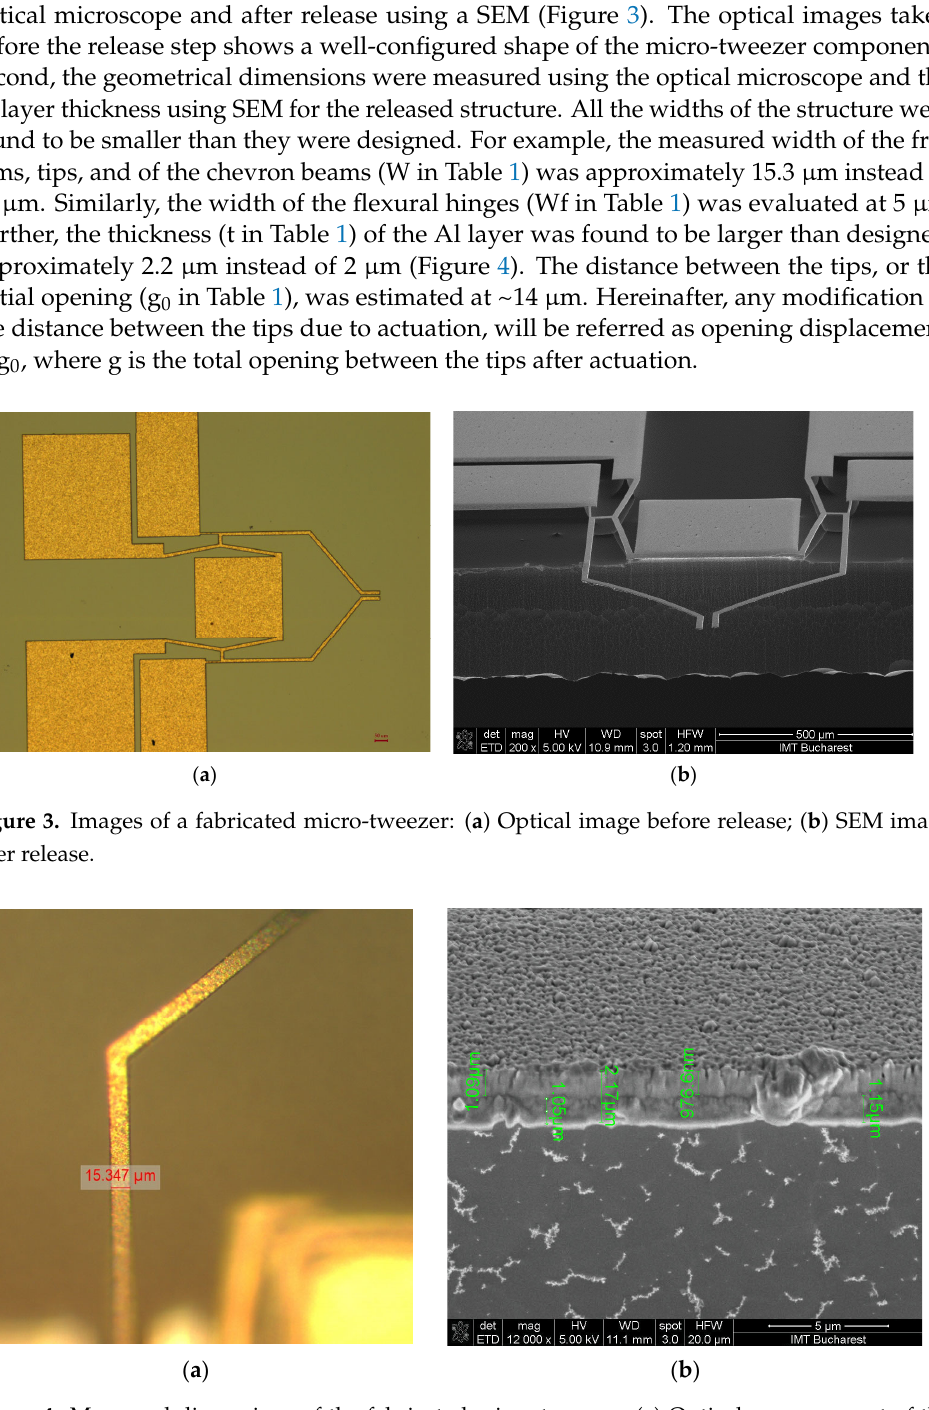
( c ) Figure 5. Micro-tweezer functional tests: ( a ) initial normally close state, at 0 mA; ( b ) open state at 160 mA; ( c ) for the last opening state after the actuation at 170 mA. A maximum opening displacement, g-g 0 , of 22 µm (or 36 µm total opening, g) was measured at an input current of 160 mA. By further increasing the current, out-of-plane displacements of the movable parts started to occur, making the operation and measure- ments unreliable. However, at an input current of 170 mA, we still managed to measure